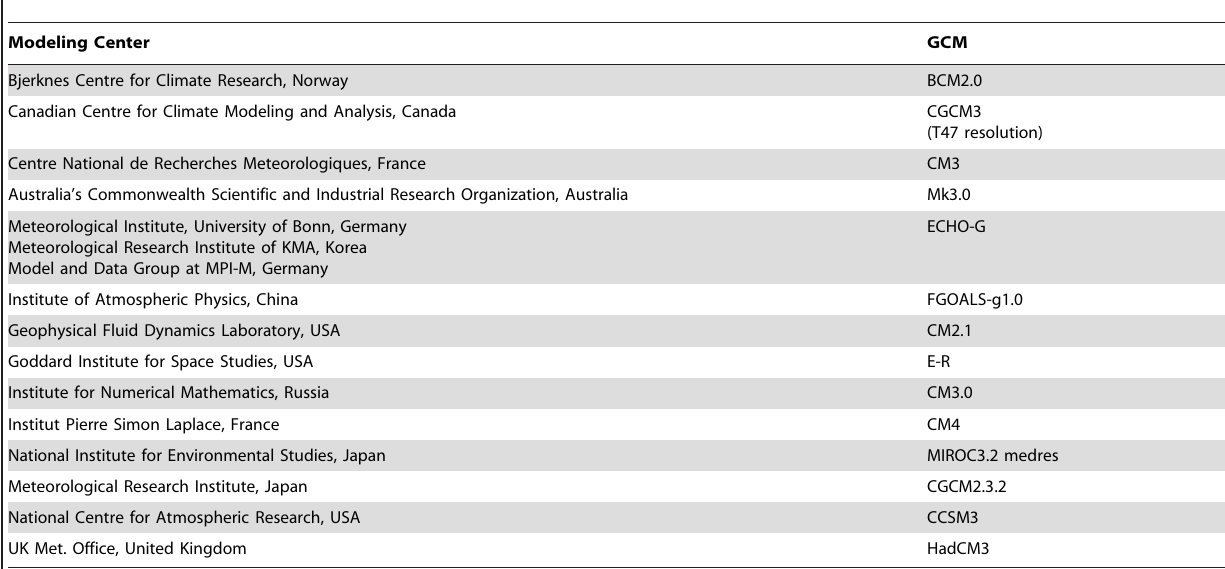
Table 2. List of general circulation models (GCMs) used in this study and their associated modeling centers.